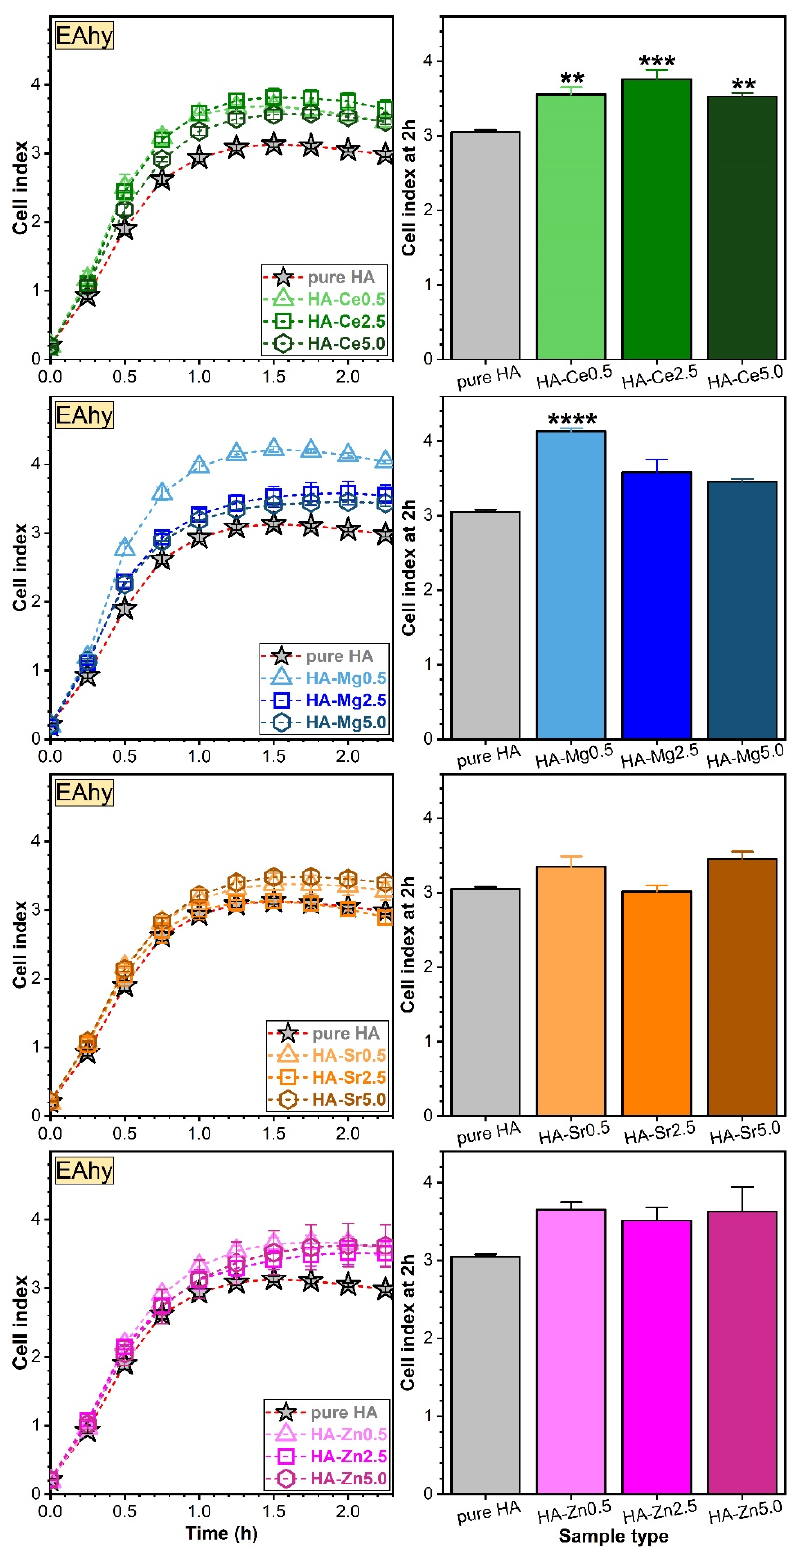
Figure 13. Impedance changes of the RTCA system mirroring the adhesion of endothelial (EAhy) cells in the presence of pure HA and Ce-, Mg-, Sr-, or Zn-substituted HA ( left panel ). Cell indices at 1.5 h were plotted as bars ( right panel ). ** p < 0.01, *** p < 0.001, and **** p < 0.0001 statistically significant differences with respect to pure HA (taken as control), as determined by using a one-way ANOVA multiple analysis followed by a Dunnett’s post hoc test.